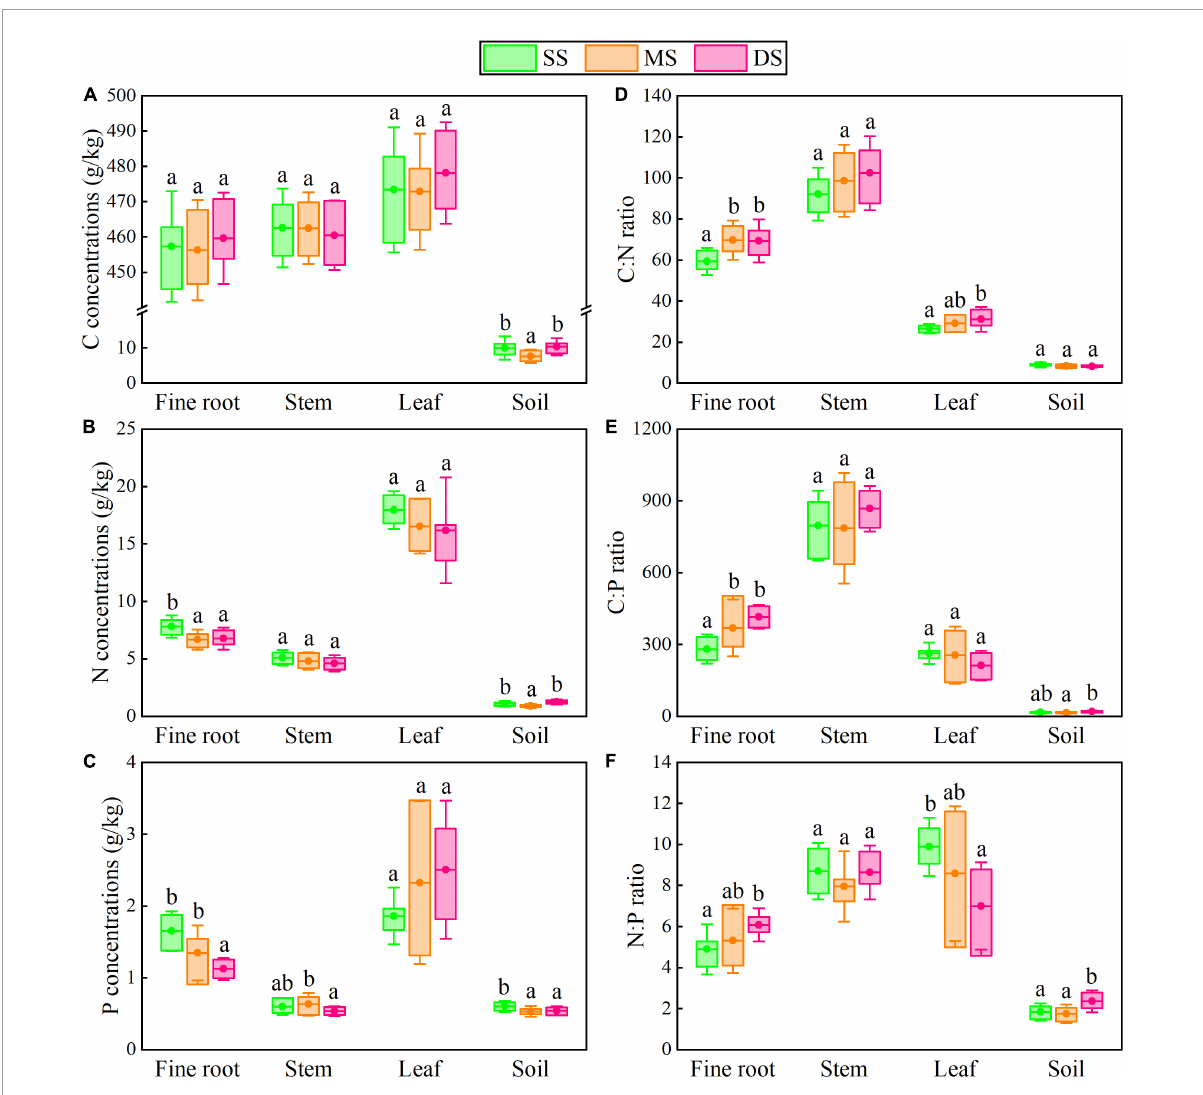
FIGURE3 The C, N, and P concentrations (A–C) and stoichiometry (D–F) in fine roots, stems, leaves, and soils of T. distichum under different submergence treatments. Data shows a significant difference with different lowercase letters ( p < 0.05) in different submergence treatments (mean with standard error). The boxes give the 25 and 75%